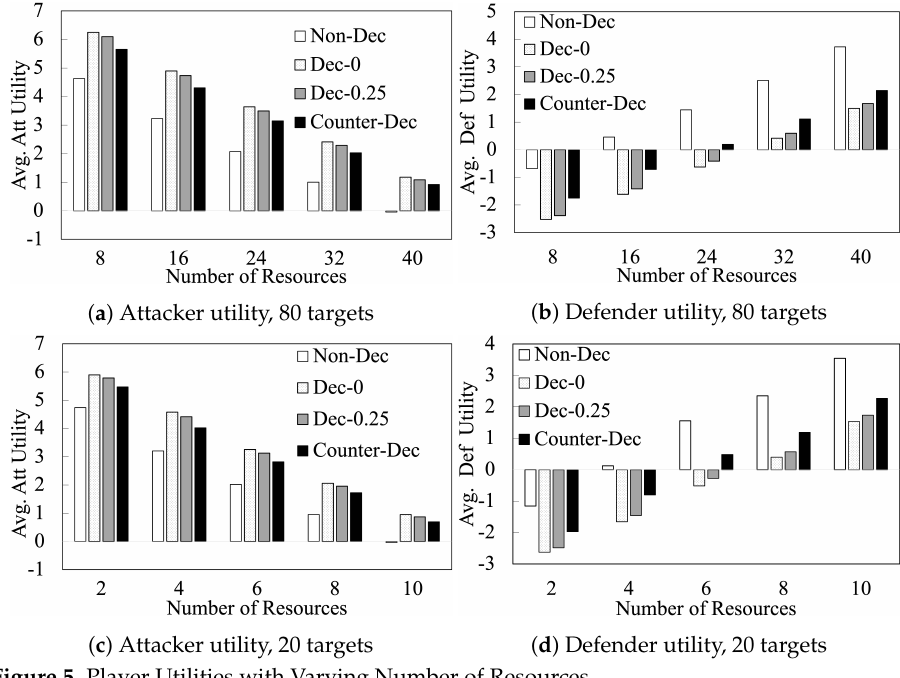
Figure 5. Player Utilities with Varying Number of Resources.